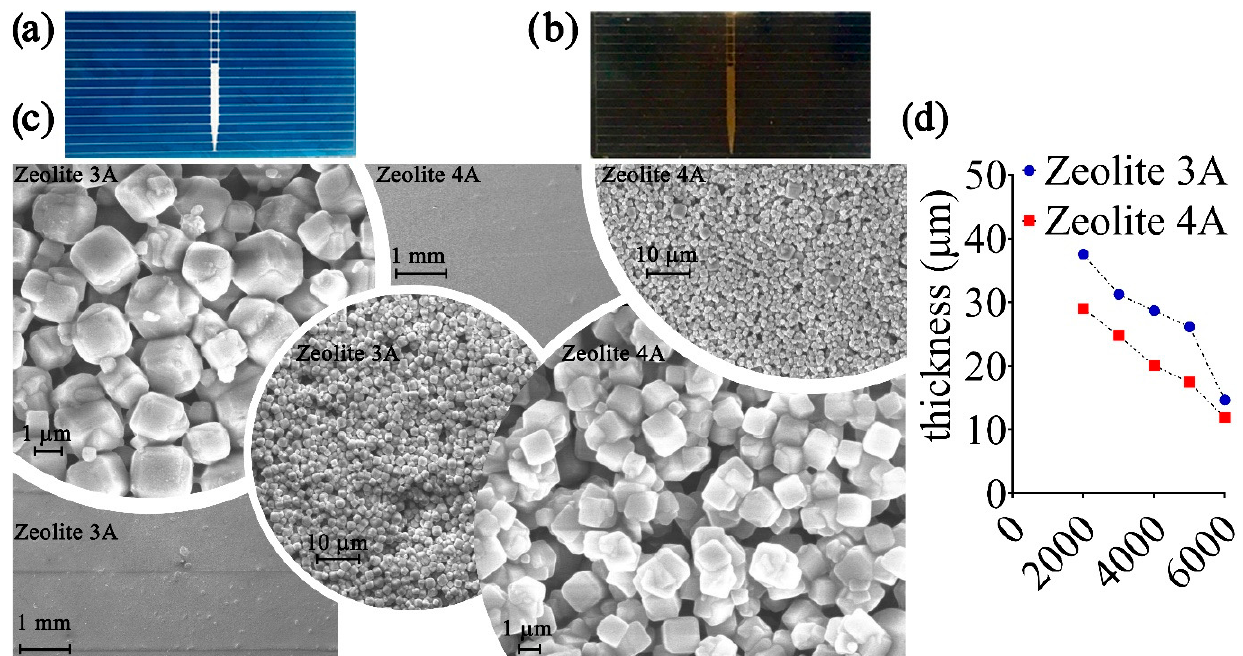
Figure 2. ( a ) Standard bare solar cell and ( b ) solar cell with anti-reflective coating. ( c ) SEM images of deposited zeolite 3A and zeolite 4A which show substantial similarity in terms of grain geometry despite the different dimensions which are smaller (about 450 nm) for type 4A as compared to type 3A (about 2 µ m). ( d ) Thickness of the ARCs vs. deposition